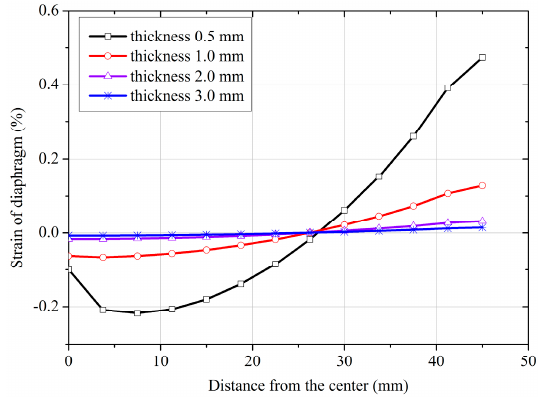
Figure 6. Simulation strain across the diaphragm for different thicknesses of the diaphragm.